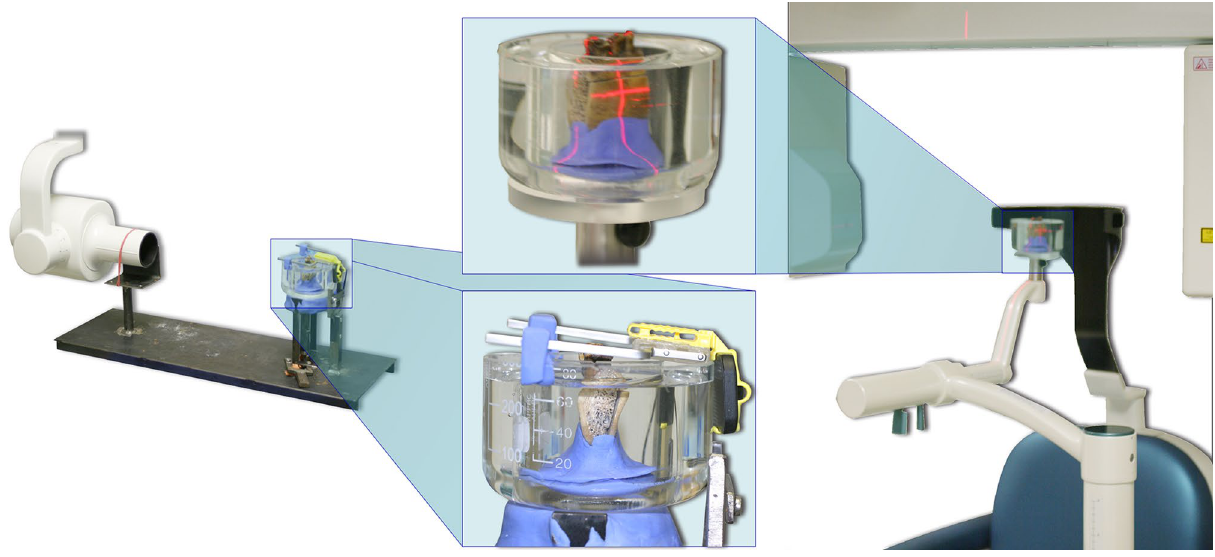
Figure 1. Reproduction of the radiological distance, angulation, soft tissue simulation and position of the specimens during exposition with DIR (left; distance between X-ray source to object: 480 mm) and CBCT (right) at all